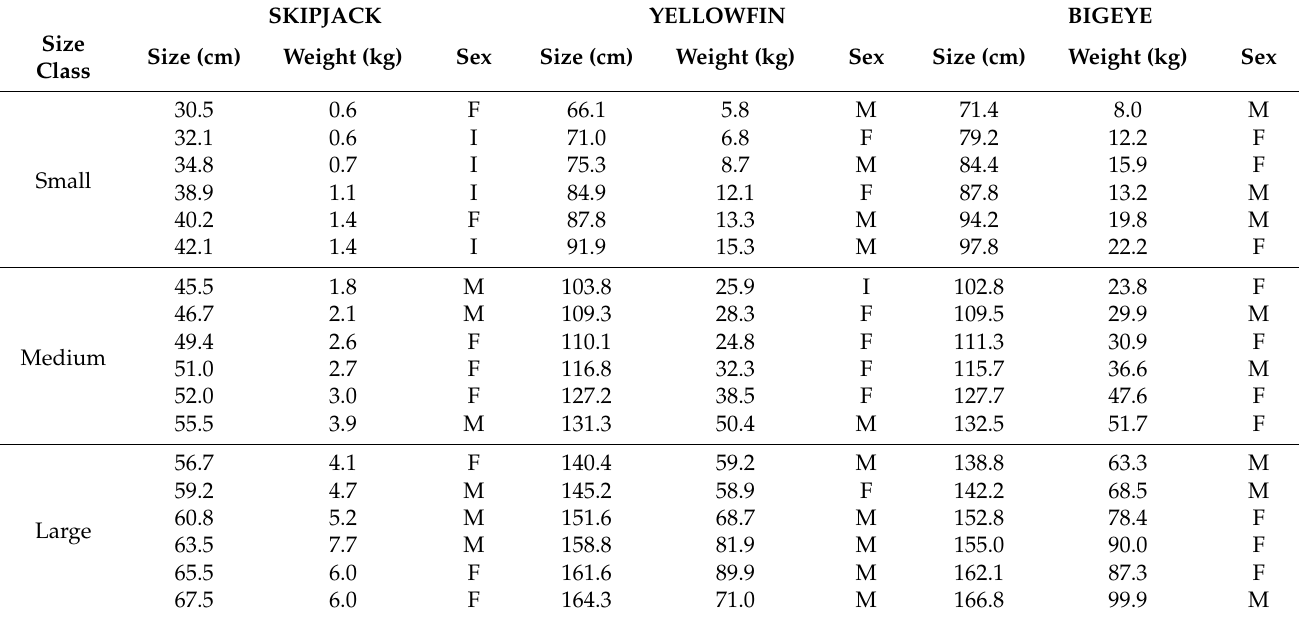
the equation: SR = minimal size/maximal size. For each species, the individuals were grouped into three equivalent categories (in terms of number), named Small, Medium and Large, and corresponding, respectively, to the 6 smallest, medium and largest fish per species (Table 1). Considering the size at 50% sexual maturity of each species [22], individuals from the Small group can be considered as being mainly juvenile or sub-adult fish, and individuals from the Medium group as sub-adults or young adults, while the Large group for each species can be considered to be composed of adults. The complete set included male, female and immature fishes but no significant difference in size or weight were observed between these three categories ( p > 0.05, Kruskal-Wallis test). Table 1. Main morphometric and sexual traits of the fish sampled in the three size categories (small/medium/large). M, male; F, female; I, Immature. SKIPJACK YELLOWFIN BIGEYE Size Class